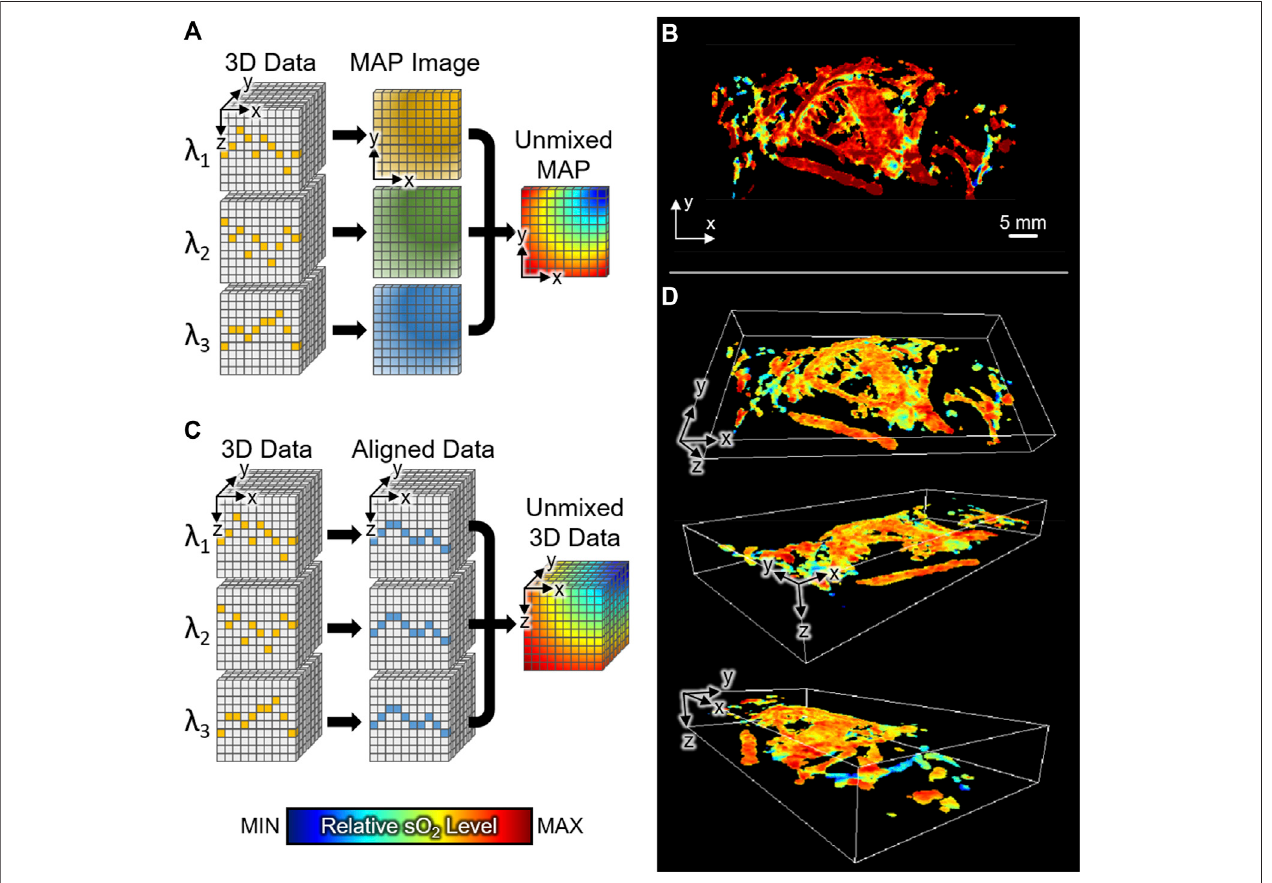
FIGURE5| TherelativesO 2 distributionofwhole-bodymice invivo . (A) SchematicillustrationofconventionalmethodforcalculatingrelativesO 2 levelinPAMac. (B) MAP image of sO 2 distribution with conventional spectral unmixing. (C) Schematic illustration of the proposed 3D unmixing method. (D) 3D distribution of whole-body sO 2 level at various angles of view. sO 2 , hemoglobin oxygen saturation; 3D, three-dimensional; MAP, maximum amplitude projection.